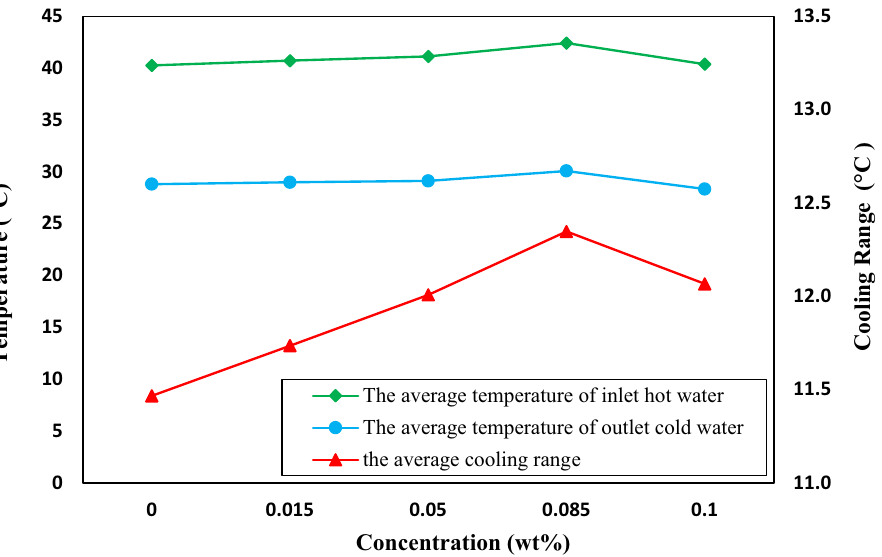
Figure 9. The average values of the inlet and outlet temperatures of the operating fluid and the cooling range of the five flow